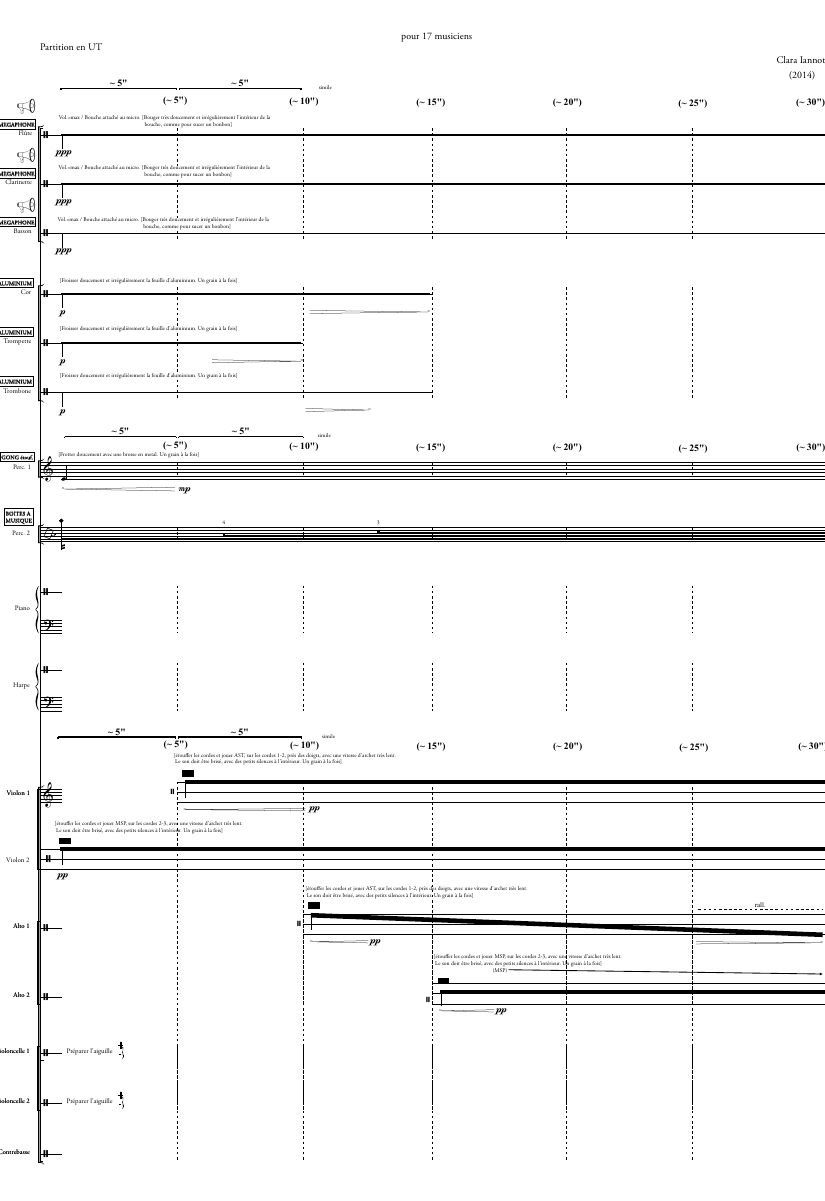
Fig. 1 First page of Clara Iannotta’s Intent on Resurrection – Spring or Some Such Thing